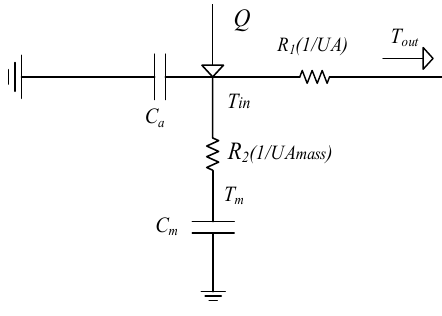
Figure 1. The simplified equivalent thermal parameter model for air-conditioning loads (ACLs).